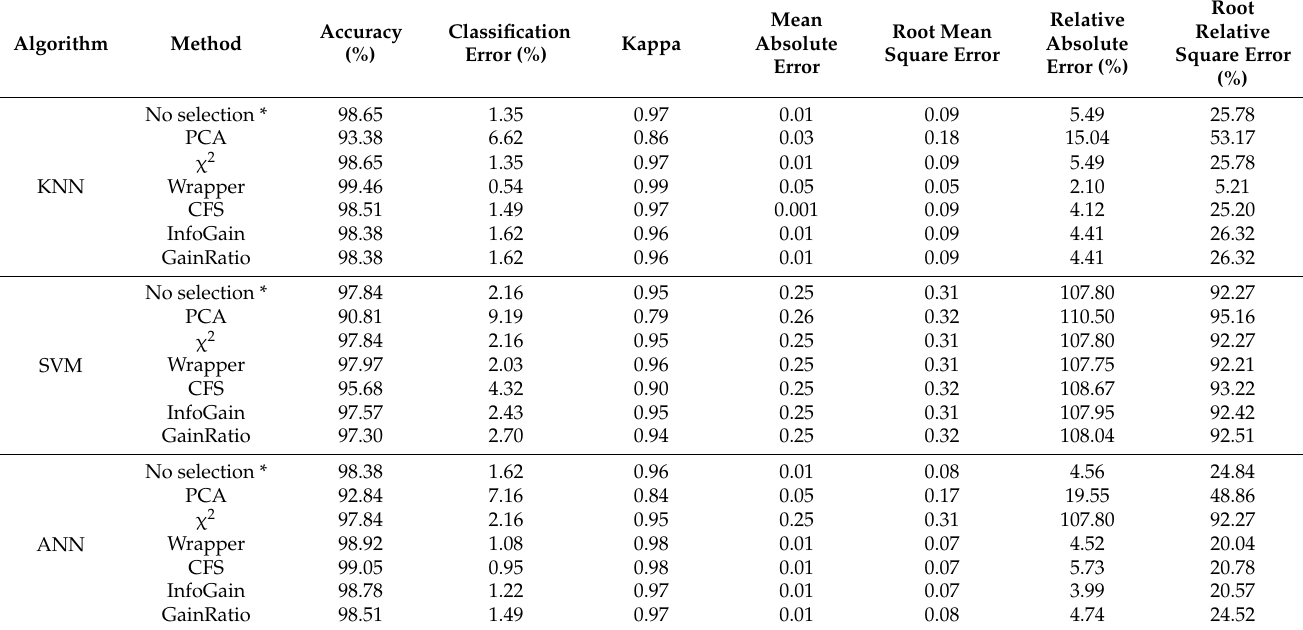
Table 7. Classifier performance metrics for four classes using Dataset 2.